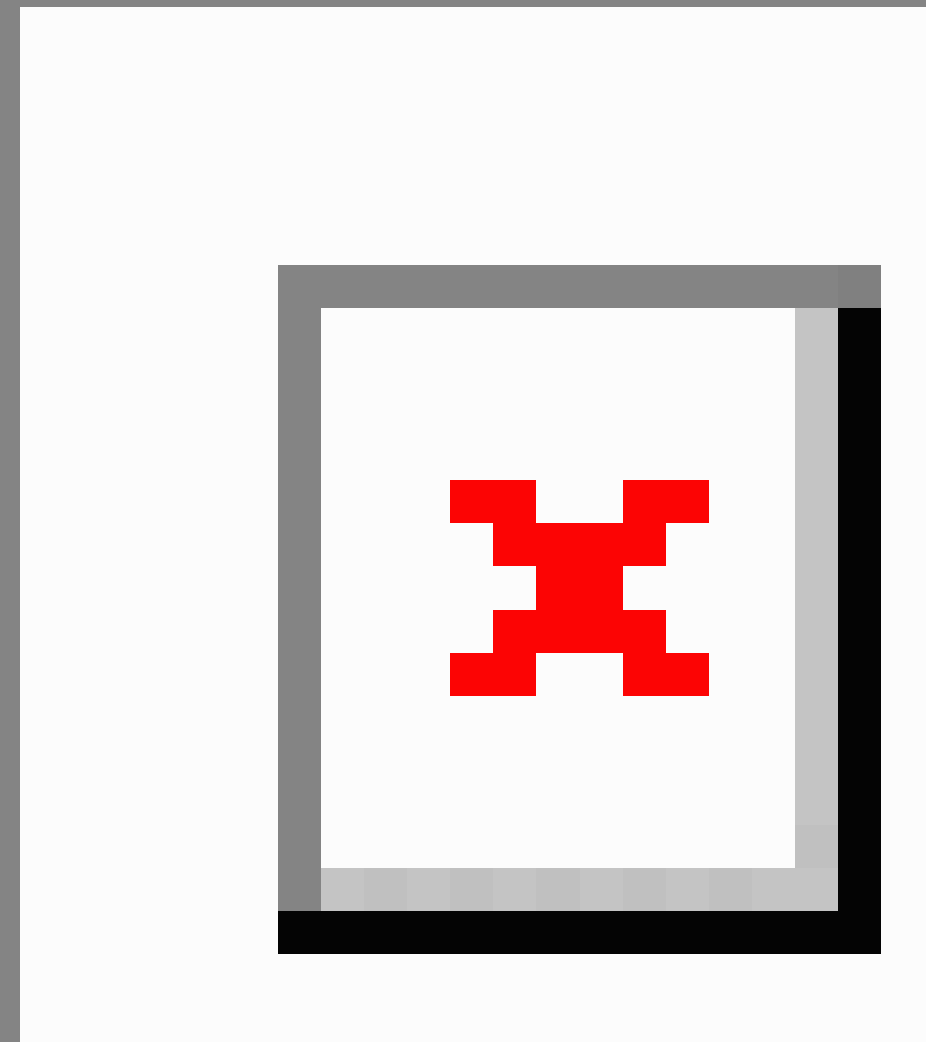
Figure 2. Sample generated HBA summary